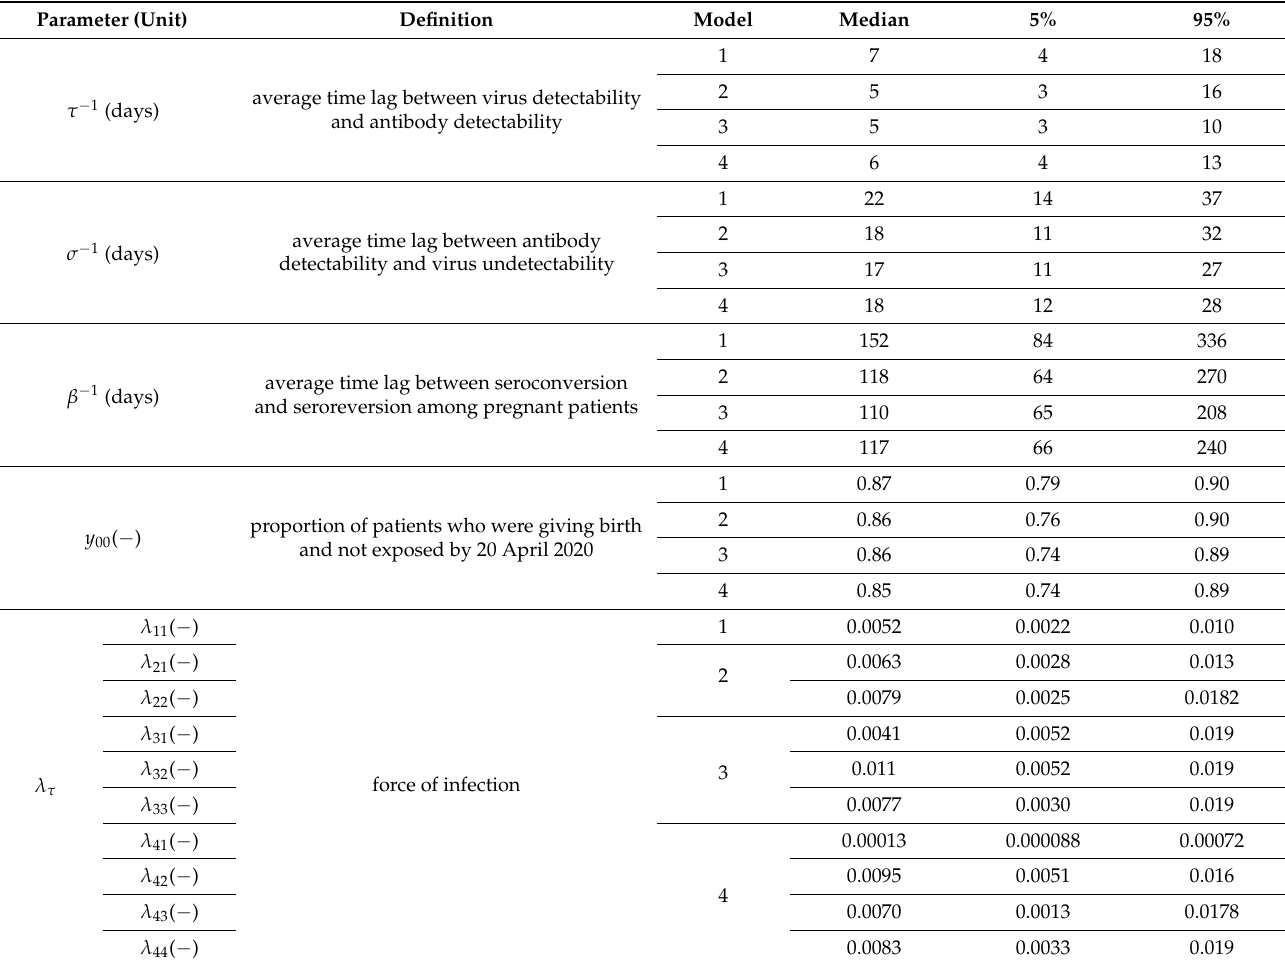
Table 3. Parameter estimates (associated 90% credible intervals) among pregnant patients for each model